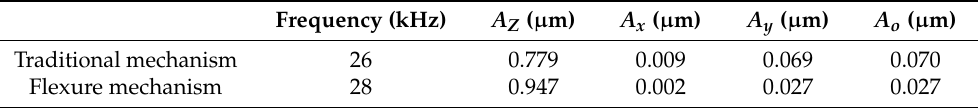
Table 5. The optimal vibration parameters of the output shaft of the two structure devices.